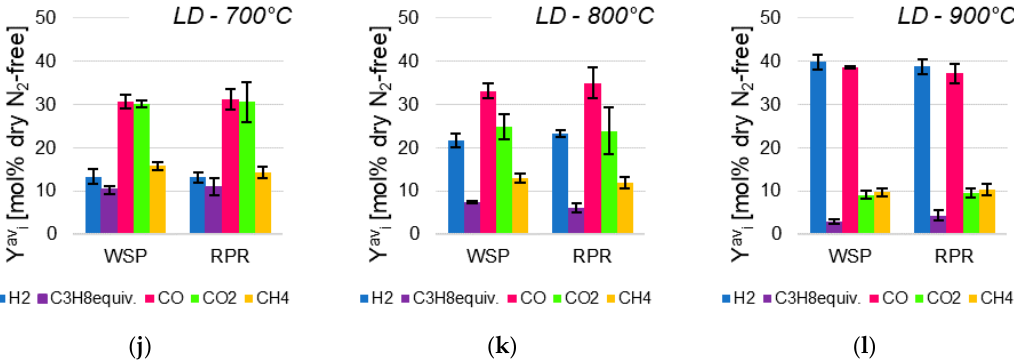
Figure 5. Experimental integral-average composition of gas from devolatilization tests as functions of temperature, kind of biomass, kind of bed material, expressed as mol% dry and dilution-free ( Y av i , Equation (2)): sand at 700 ◦ C ( a ), 800 ◦ C ( b ), 900 ◦ C ( c ); ILM at 700 ◦ C ( d ), 800 ◦ C ( e ), 900 ◦ C ( f ); SIB at 700 ◦ C ( g ), 800 ◦ C ( h ), 900 ◦ C ( i ); LD at 700 ◦ C ( j ), 800 ◦ C ( k ), 900 ◦ C ( l ).